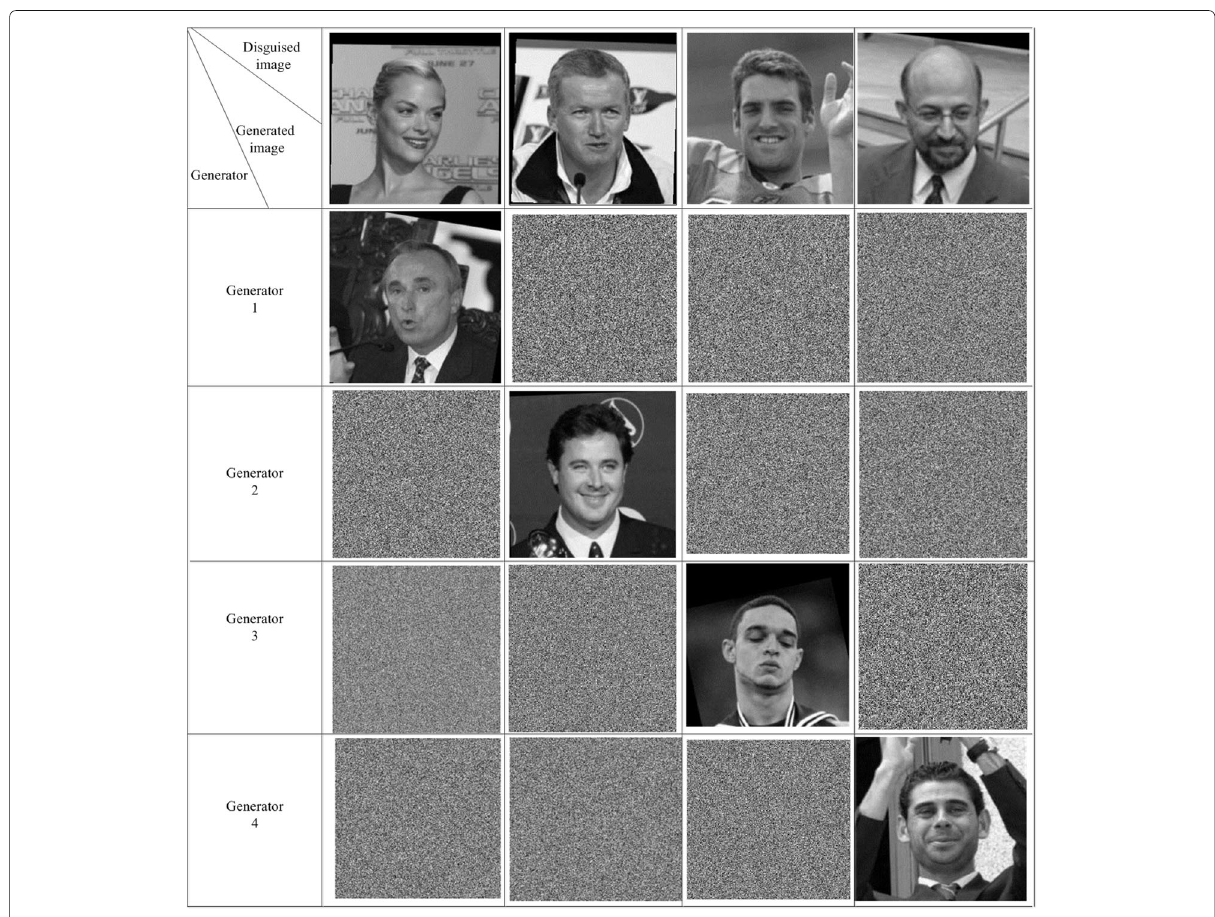
Fig. 10 Safety verification of experiment